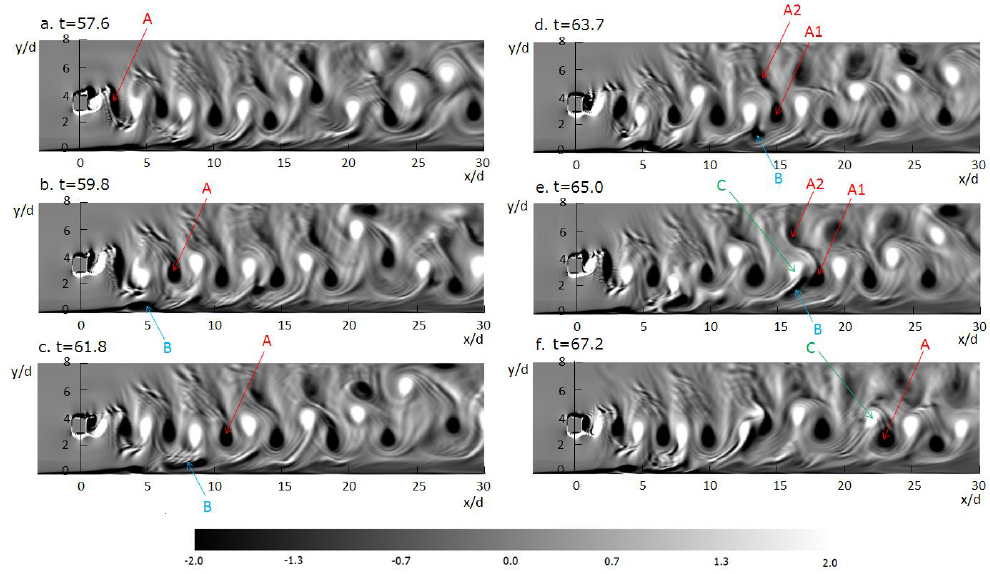
Fig. 4 Time sequence of the normalized spanwise vorticity in the case of 0.3/  dC (black and dark gray: negative; white and light gray: